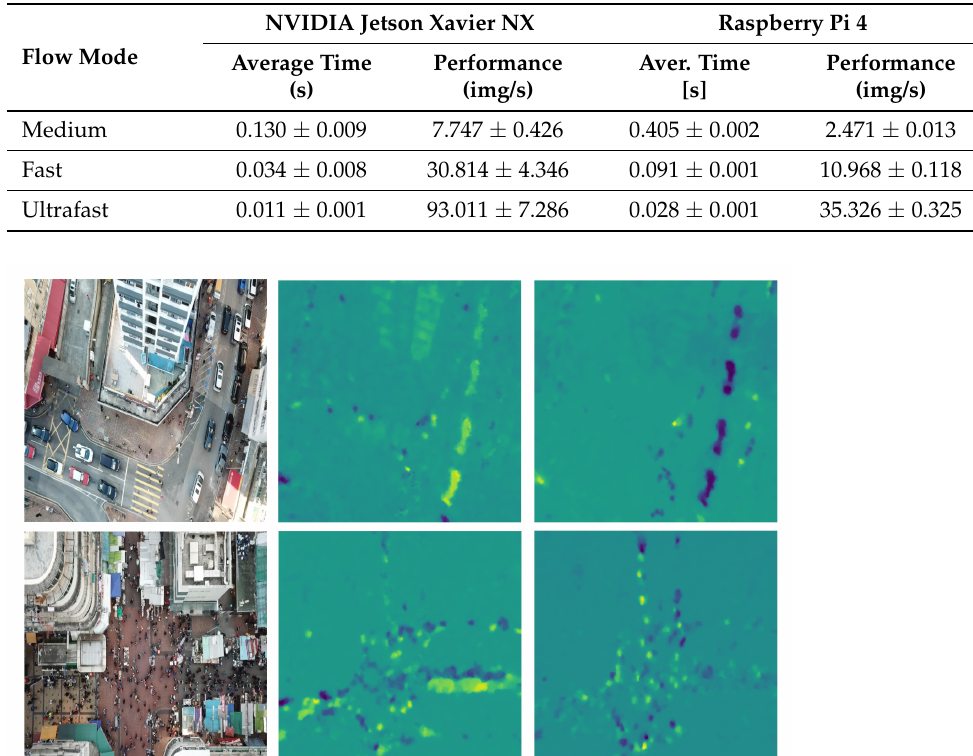
Table 1. Effect of changing the optical flow generation mode for 1280 × 736 resolution.